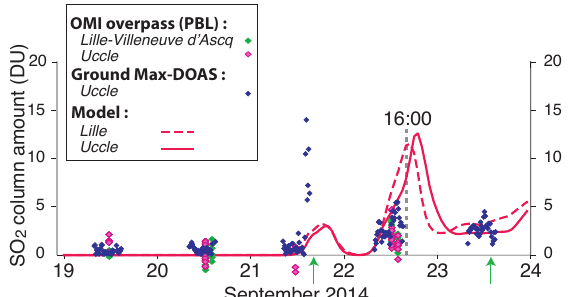
Figure 9. Time series of SO 2 vertical column amount above Uccle (Belgium) and Lille (France) from CHIMERE CT model (dashed and solid red lines for Lille and Uccle resp.), OMI PBL overpass (green and pink diamonds for Lille and Uccle resp.) and ground- based UV MAX-DOAS observations in Uccle (blue diamonds). Green arrows indicate when OMI overpasses above Lille are miss- ing due to gaps in data related to sensor “row